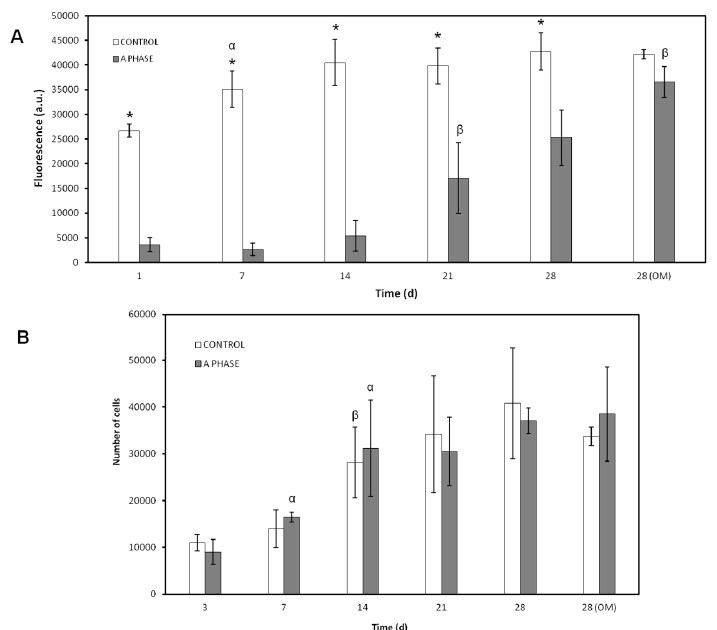
Figure 3. ( A ) Cellular metabolic activity of the cells seeded on the Nurse’s A-phase scaffolds compared to cell cultures on plastic (positive controls) obtained by means of Alamar Blue Assay; ( B ) Proliferation assay of the cells seeded in indirect contact with Nurse’s A-phase compared to cells growing on plastic used as control. (*) denotes significant differences ( p < 0.05) between Nurse’s A-phase and control at the same experimental time; ( α ) denotes significant differences ( p < 0.05) between different experimental times obtained for control samples; ( β ) denotes significant differences ( p < 0.05) between different experimental times obtained for cells growing on Nurse’s A-phase scaffolds.